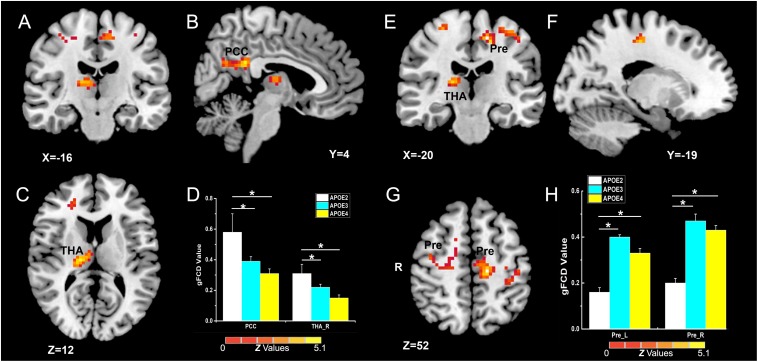
Primary outcome of the APOE genotypes on gFCD (p < 0.005; α < 0.001; 3dClustSim corrected). (A–C,E–G) Influence of APOE genotype on the brain functions of different brain regions. (D,H) The histograms quantitatively illustrate the gFCD differences among the three APOE genotypes. The asterisks mean significant difference between two APOE genotype groups. Compared to APOE ε3ε3 and ε4+ genotypes, the APOE ε2 + genotype show higher gFCD values in the PCC and right thalamus (D), and lower gFCD values in the bilateral precentral gyrus (H). No significant difference was found in brain functions between the two APOE ε3ε3 and ε4+ genotype groups. gFCD, global functional connectivity density; PCC, posterior cingulate cortex; THA, thalamus; Pre, precentral gyrus.